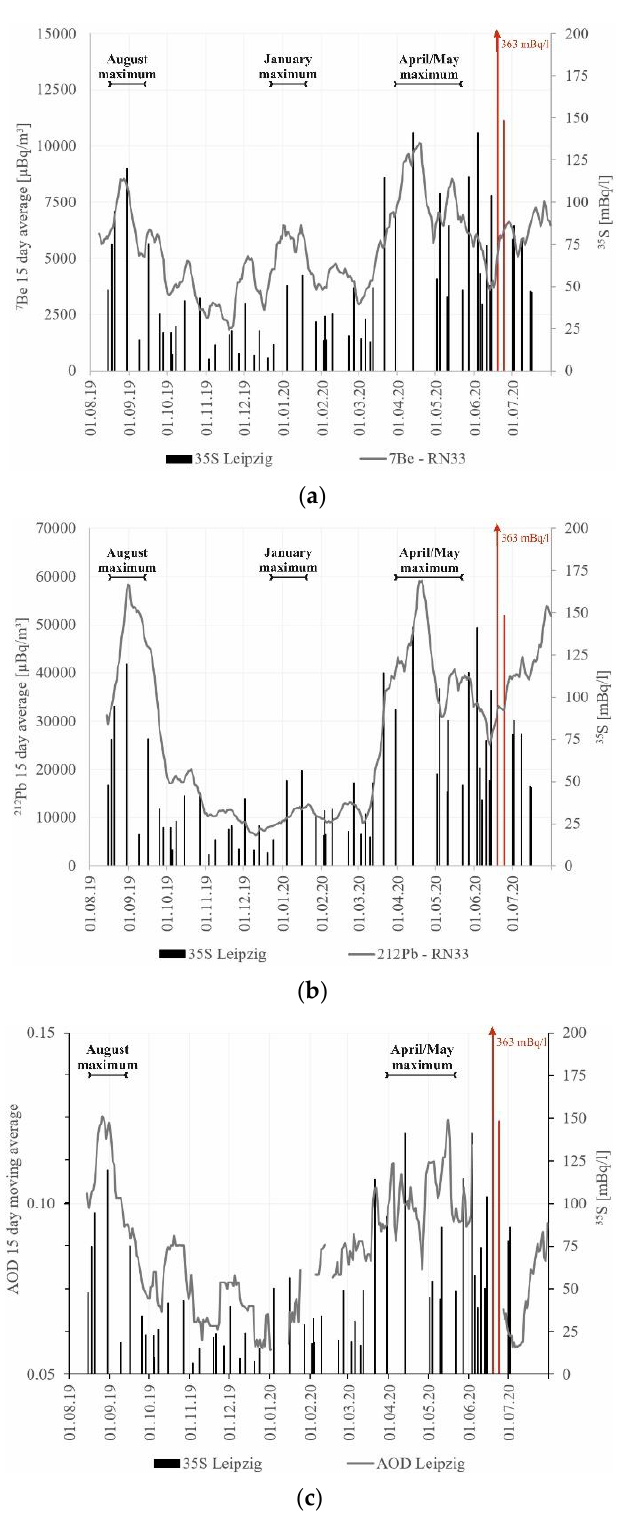
Figure 4. Time series ( a ) 35 S/ 7 Be, ( b ) 35 S/ 212 Pb, and ( c ) 35 S/AOD (at wavelengths 1640 and 1020 nm), respectively. The 35 S axis is scaled to a maximum value of 200 mBq/L, with the peak recorded in late June (max. 363 mBq/L) marked in red but not fully shown ( cf. Figure 5). The unusually high AOD values recorded around this peak (max. 0.161) are not displayed either ( cf. Figure 5).